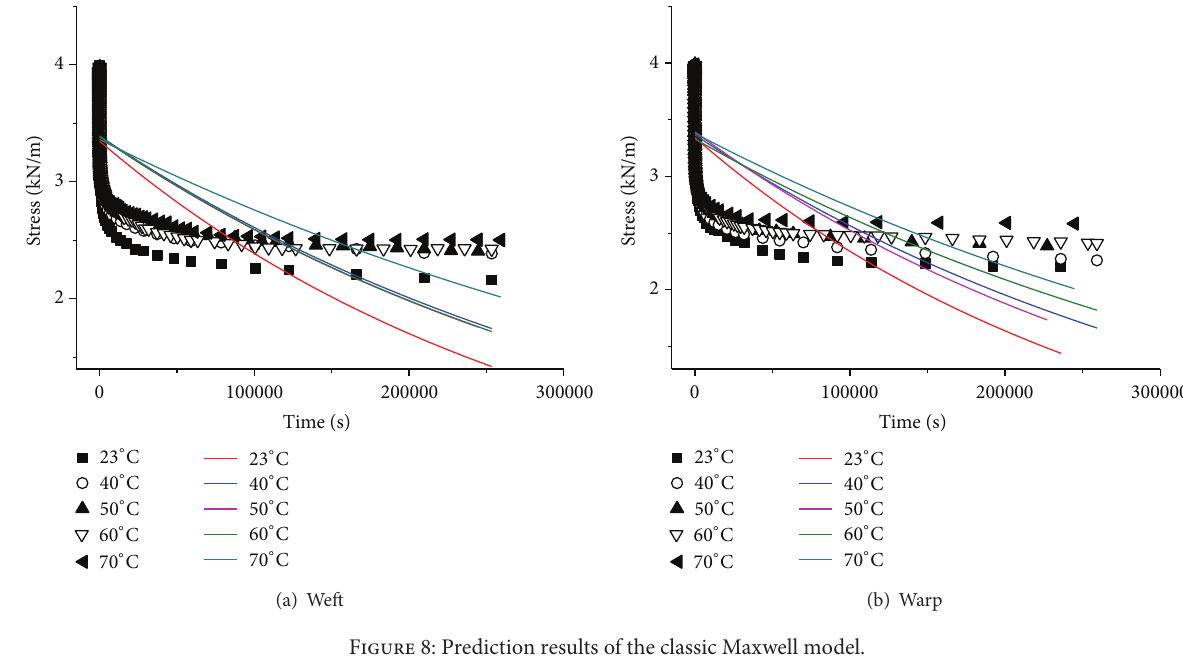
Figure 8: Prediction results of the classic Maxwell model.